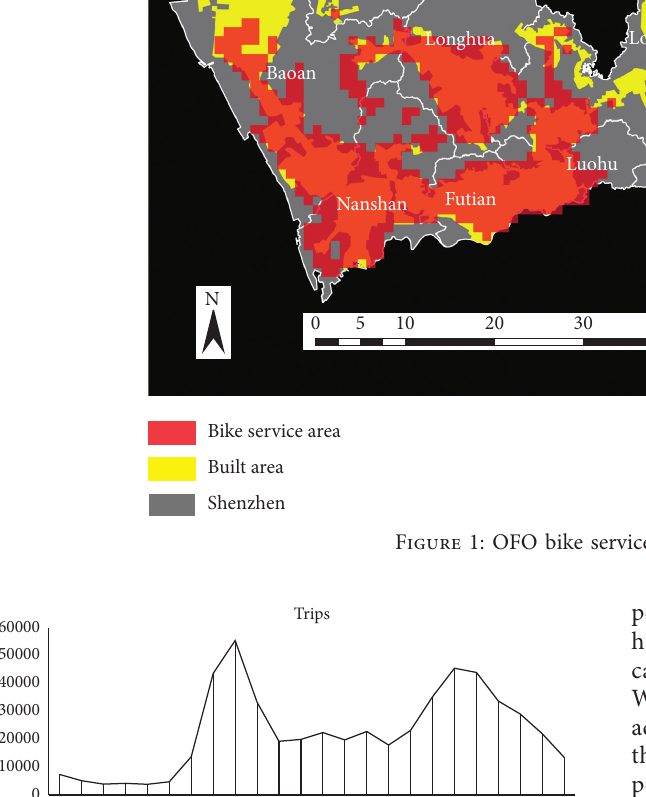
Figure 2: The number of sharing bicycle trips in 24 hours in a workday.